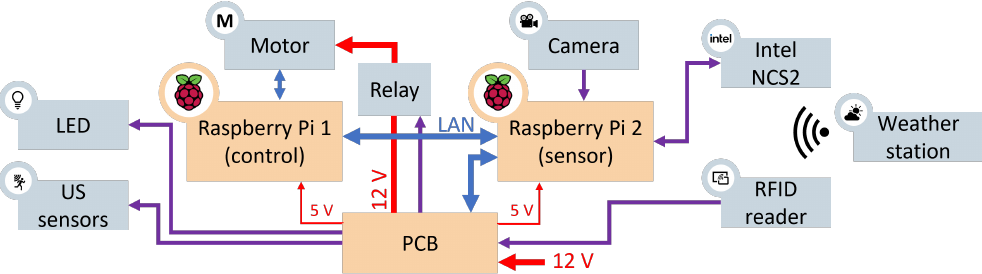
Figure 2. Hardware architecture. The red arrows symbolise the power link, the blue ones the data, and the purple ones